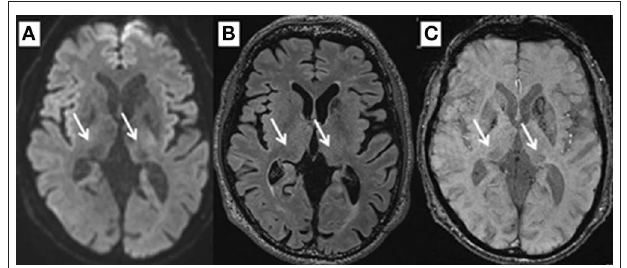
FIGURE 1 | Pulvinar hypointensity MRI of a 61-year-old man in DWI (A) , FLAIR (B) , and SWI (C)